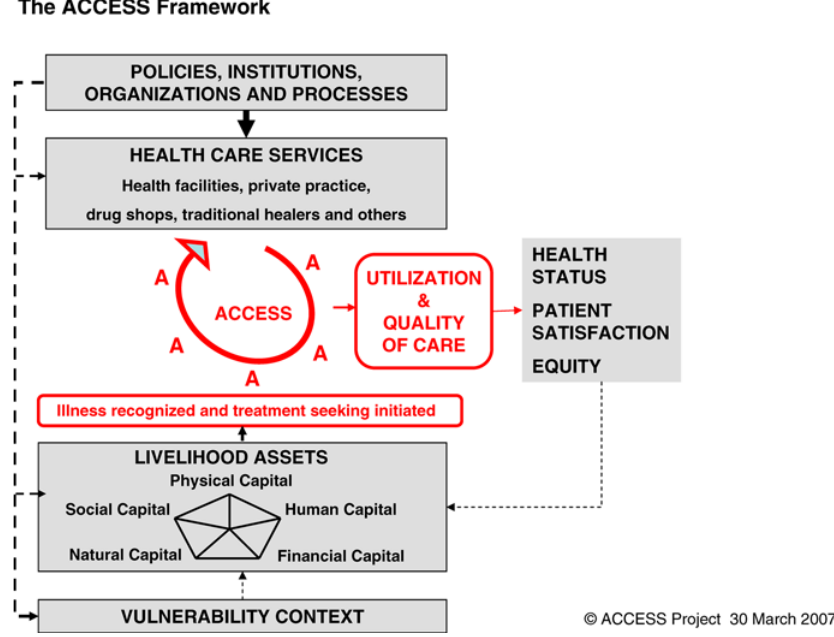
Figure 1. The Health Access Livelihood